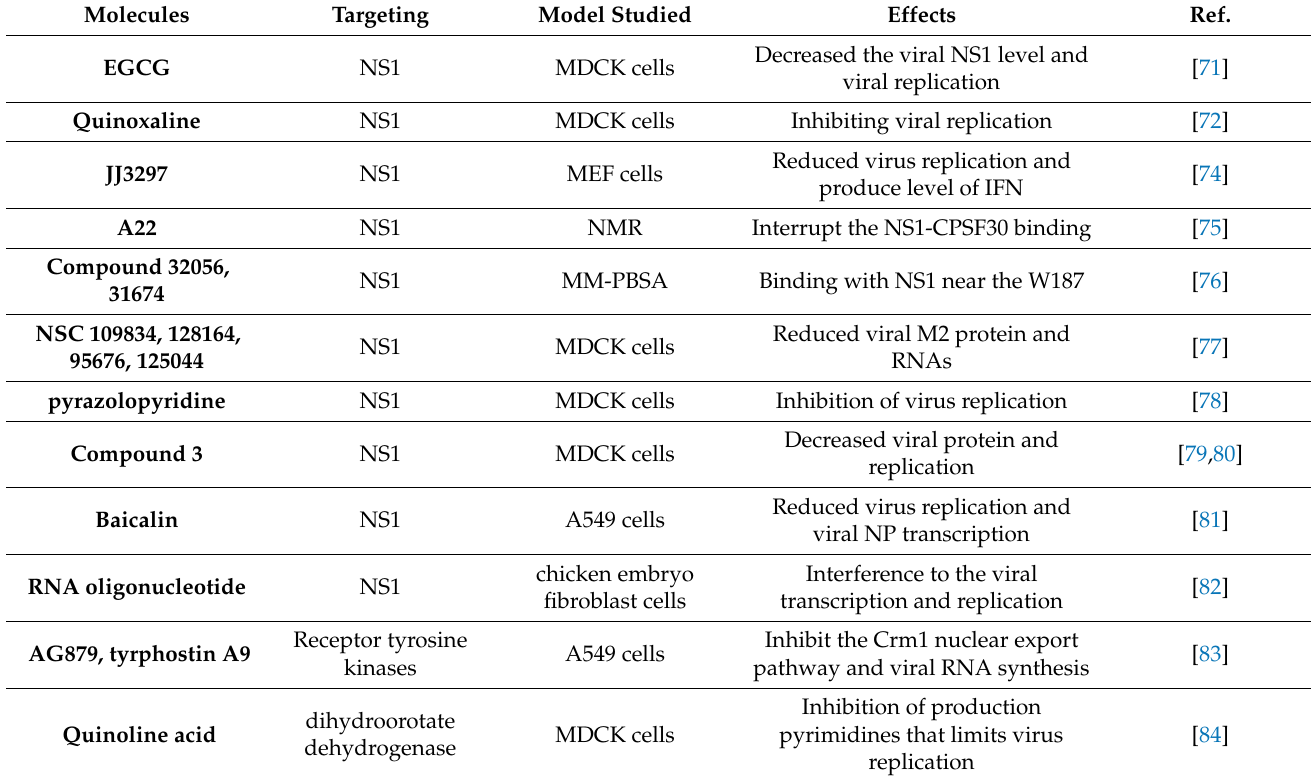
Table 1. Small-molecule inhibitors of influenza